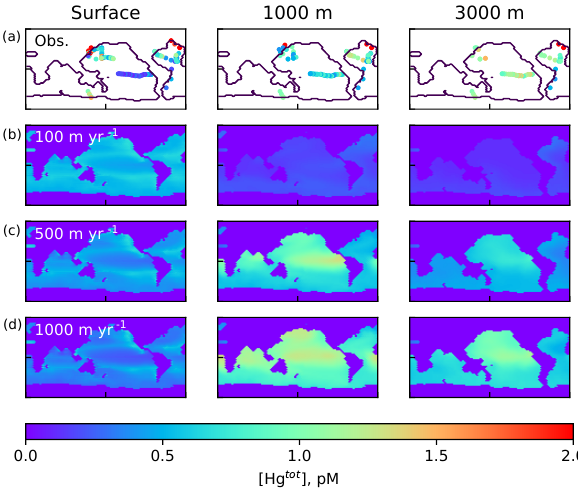
Figure 2. Comparison of Hg(tot) concentrations in pM from the model with data in the top row, from Laurier et al. (2004), Bow- man et al. (2015), Bowman et al. (2016), Cossa et al. (2004), Cossa et al. (2011), Hammerschmidt and Bowman (2012), Lamborg et al. (2012), Mason et al. (2001), and Mason et al. (1998), at approx- imately the depths in the ocean given at the top. The lower three rows are present-day (year 2010) model results using different val- ues of the particulate-bound Hg sinking velocity as indicated by the labels on the left, with 500myr − 1 as the base case.